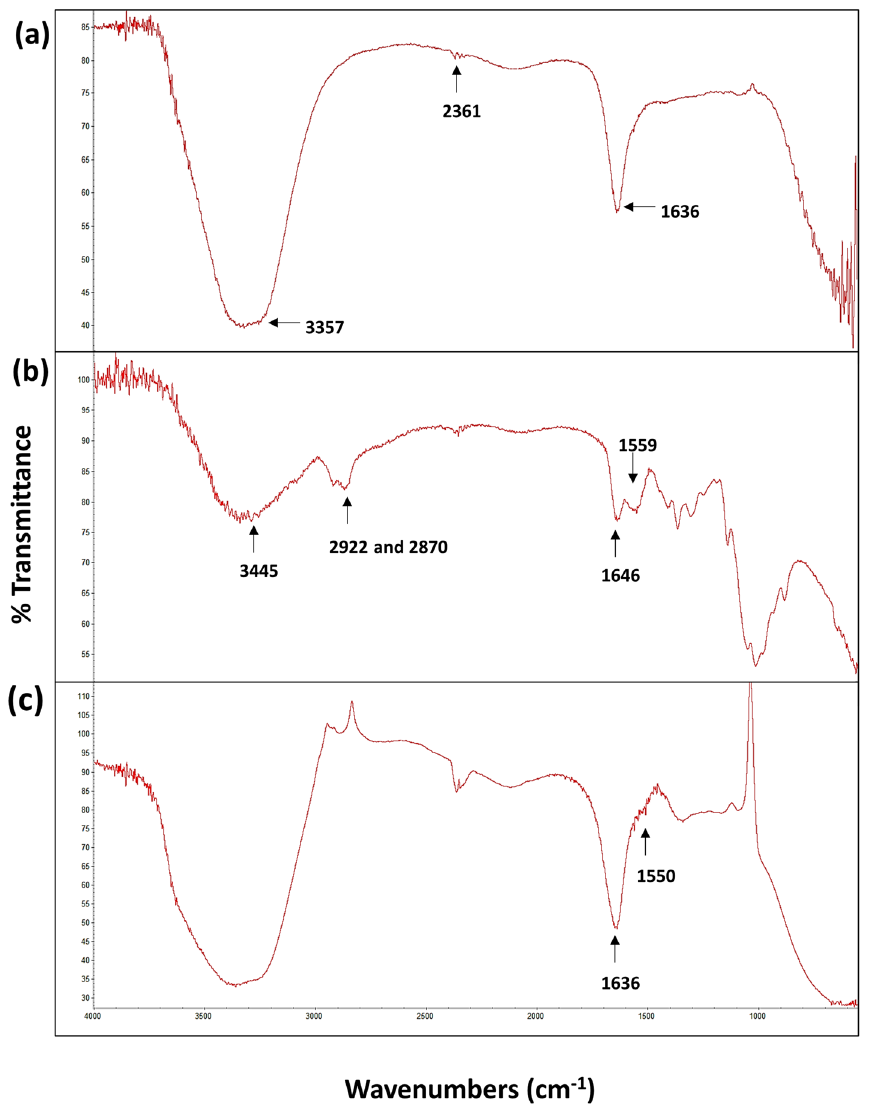
Figure 4. Determination of functional groups using fourier transform infrared spectroscope. ( a ) spectral analysis of silver nanoparticles (AgNPs), ( b ) spectral analysis of chitosan and ( c ) spectral analysis of silver nanocomposite system